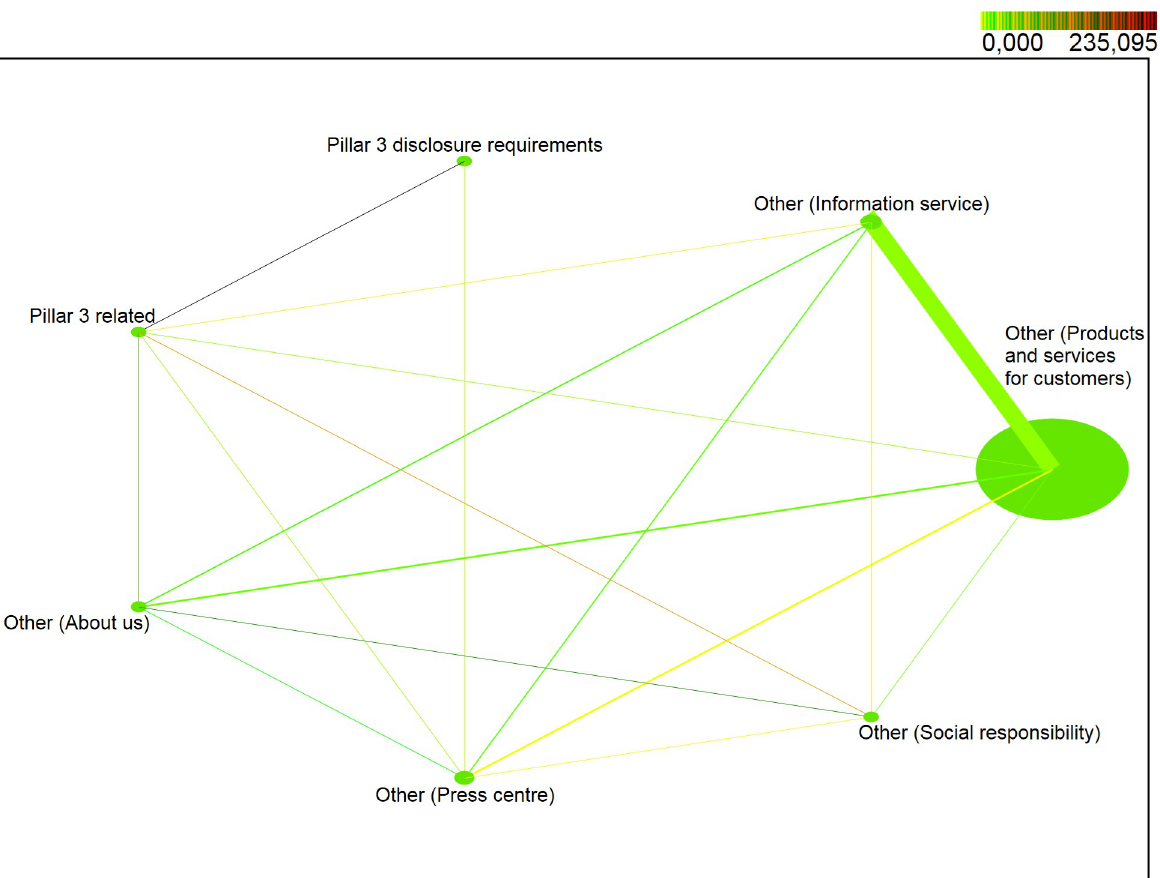
Fig 2. Visualization of frequented web parts of the first quarter of